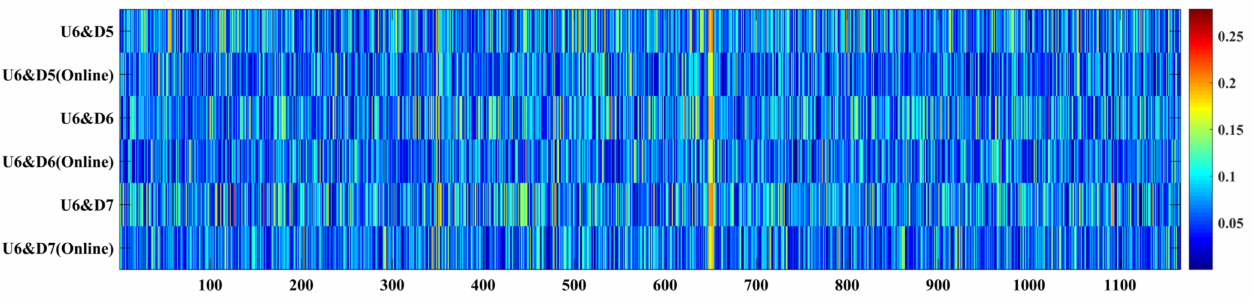
Figure 14. The stride-length errors of the offline model (SLE model without online learning module) and updated model (SLE model with online learning module) with different